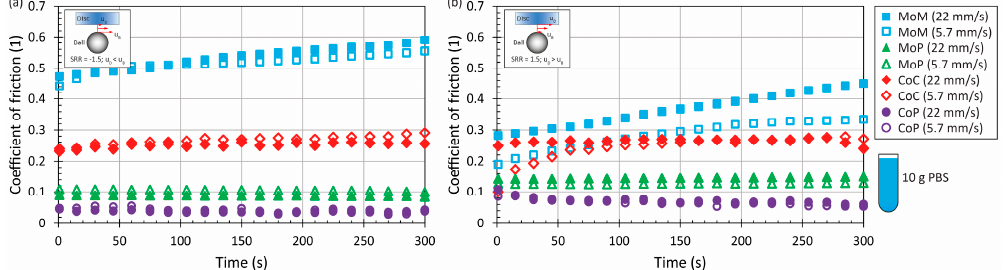
Figure 2. Development of coefficient of friction (CoF) as a function of time for four material combinations at lower and higher mean speed under negative ( a ) and positive ( b ) sliding conditions. Contact is lubricated by phosphate-buffered saline (PBS).